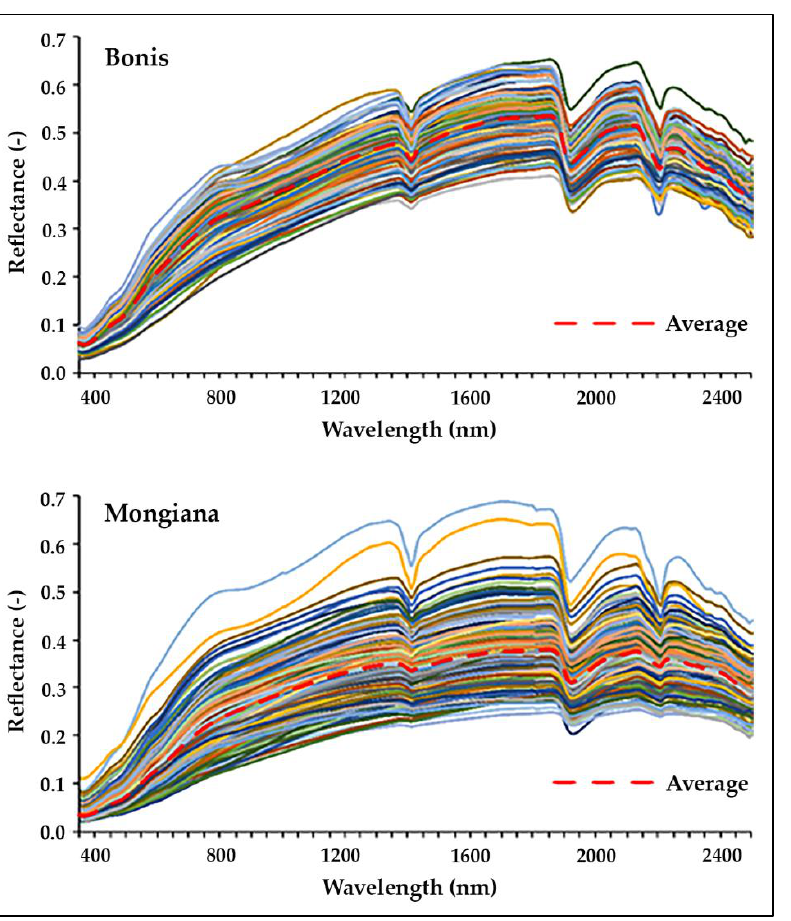
Figure 2. Diffuse reflectance spectra for all topsoil samples at both study areas. For each study area, the average reflectance spectrum (dashed red line) is also shown.